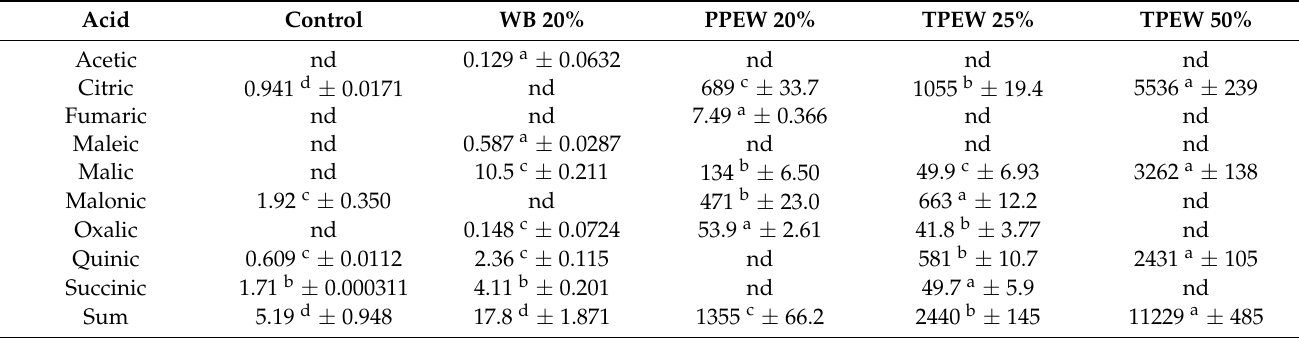
Table 2. Content of aliphatic low-molecular organic acids (LMWOAs) (µg g − 1 DM) in fruit bodies of Pleurotus citrinopileatus growing at substrates enriched with different supplements.